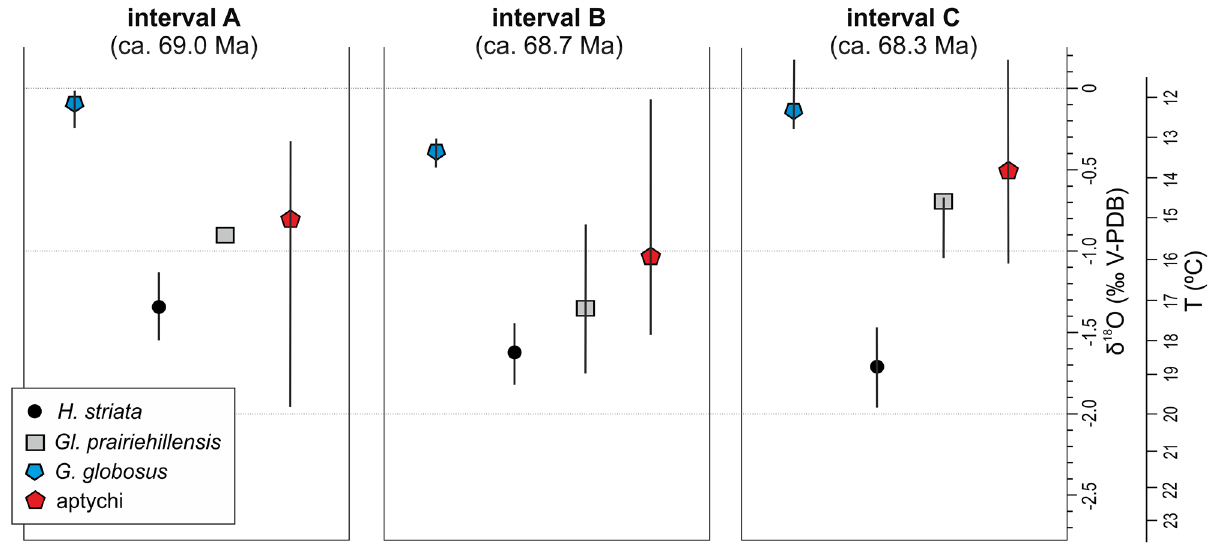
Figure 3. Box and whisker plots of δ 18 O data for targeted foraminifera and aptychi of Hoploscaphites constrictus from intervals A–C at Chełm, grouped by taxon. Each box represents the mean value and whiskers are extended between the maximum and minimum δ 18 O values. H. , Heterohelix ; Gl. , Globigerinelloides ; G. , Gyroidinoides